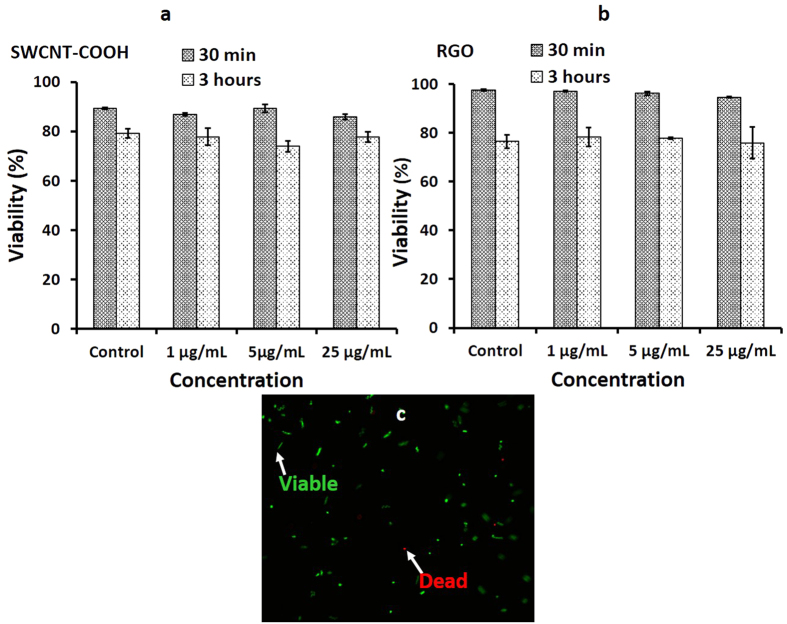
Sperm viability analysis after incubation with nanomaterials.Viable sperm population (control, 1, 5, and 25 μg/mL) after incubating with (a) SWCNT-COOH and (b) RGO for 30 minutes and 3 hours. (c) Fluorescent image of viable (green) and dead (red) sperm were used for viability quantification.